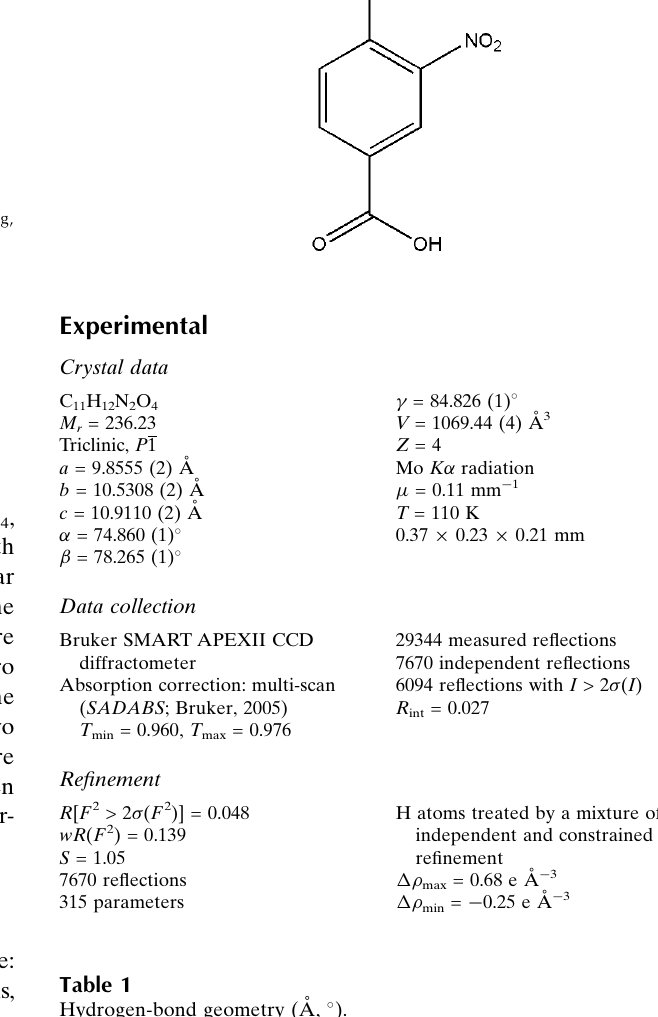
Hydrogen-bond geometry (A˚ , (cid:3)